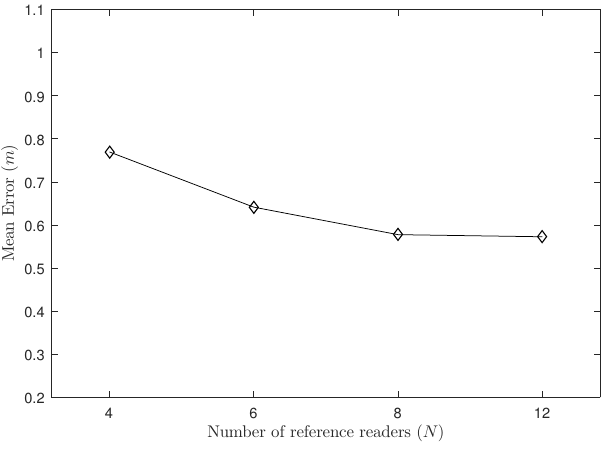
Figure 4. The Influence of the Number of